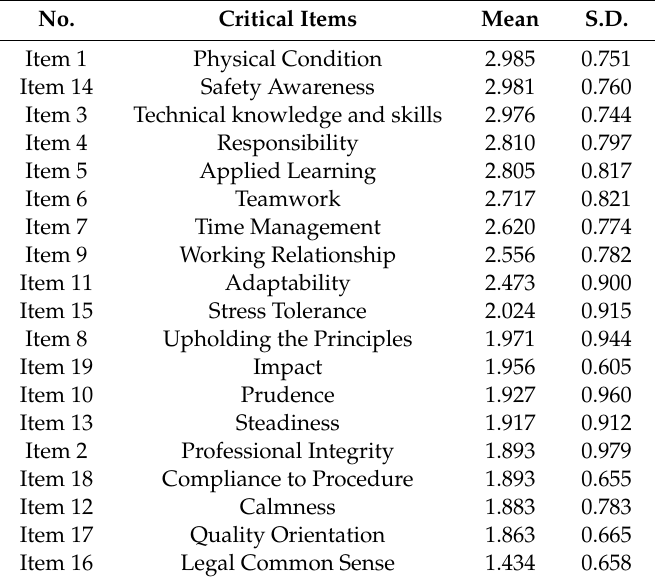
Table 4. The statistical description of critical items a ff ecting workers’ safety competency.